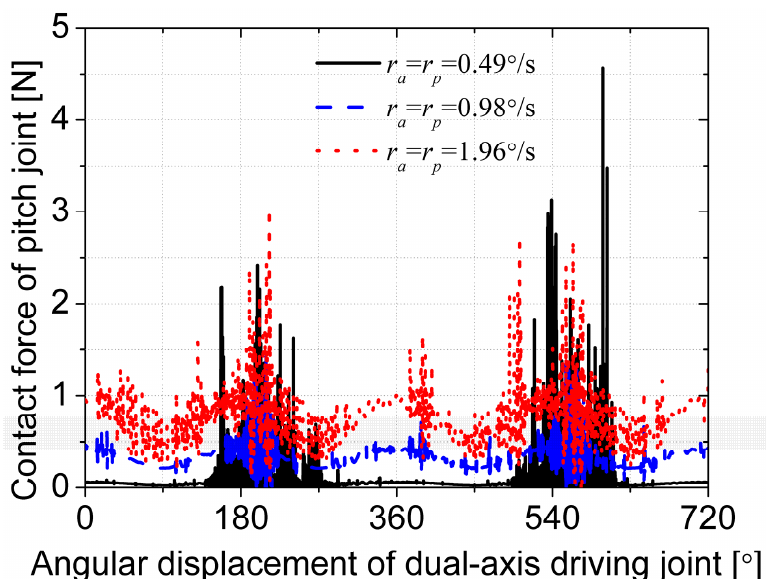
Figure 18. The radial contact force of pitch joint output side with different rotational speeds.